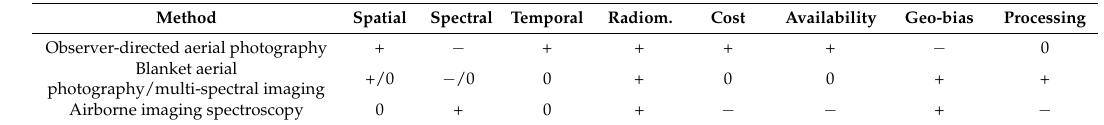
Table 1. Overview of the main passive imaging solutions in the optical domain and how they score for the eight key characteristics. +, 0 and − indicate good, neutral and bad, respectively. Scoring is specifically for archaeological purposes and established by mutually weighing all solutions.